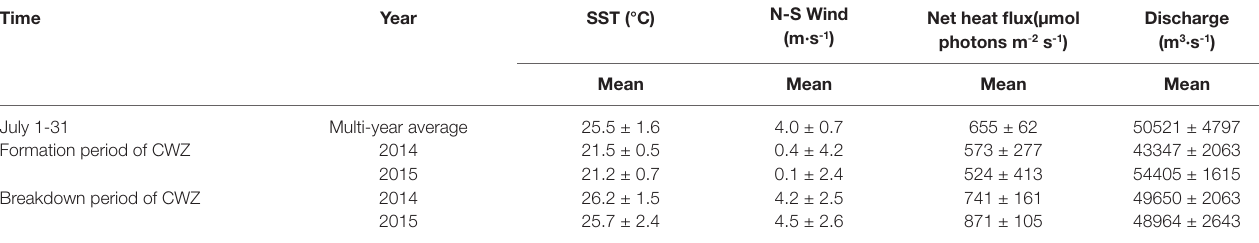
TABLE 2 | Mean and standard deviations of SST, north-south wind speed (the positive value represented southerly wind speed), net heat flux at the center of CWZ (123.5°E, 32°N) in the YS, and the discharge at Datong station during July 1–31 of multi-year average and period of CWZ formation (July 1–17, 2014 and July 3–19,